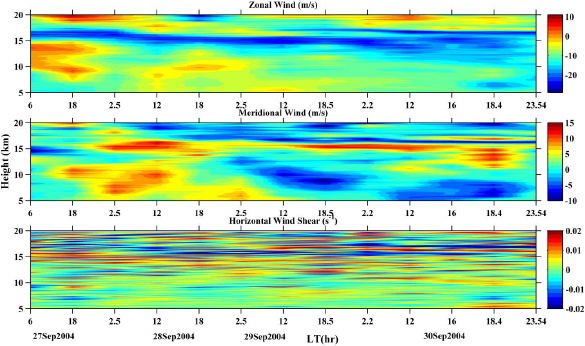
659 Figure 4. Height-Time section of background zonal wind (ms -1 ) (top), meridional (ms -1 ) wind 660 Fig. 4. Height–time section of background zonal wind (ms − 1 ) (middle) and corresponding horizontal wind shear (s -1 ) (bottom) for 27-30 September 2004. 661 (top), meridional (ms − 1 ) wind (middle) and corresponding hori- zontal wind shear (s − 1 ) (bottom) for 27–30 September 2004.